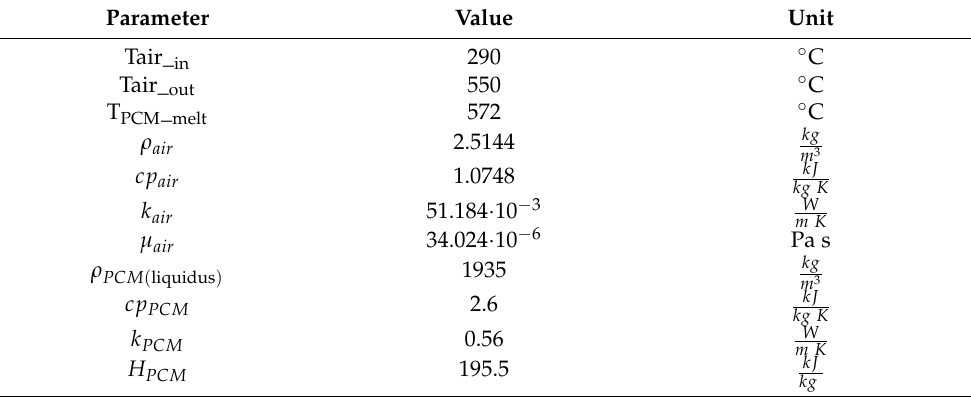
Table 6. Thermophysical equation for both HTF (air) and PCM: specific heat, density (apparent